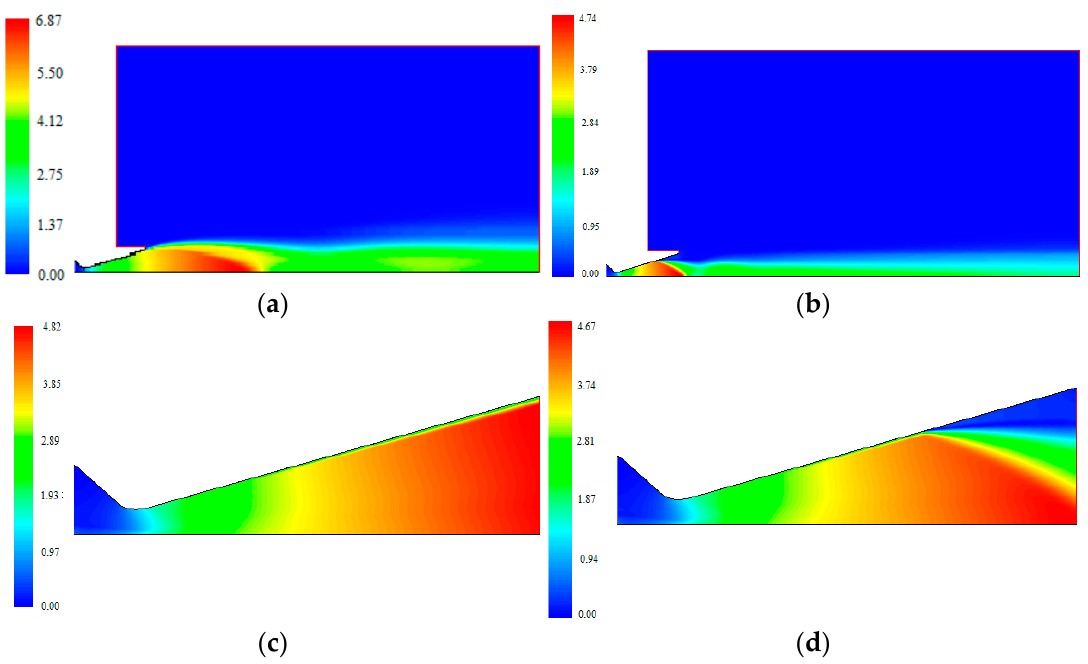
Figure 8. Mach number of cloud map of flow field, Pc = 4.34 MPa. ( a ) High altitude full field. ( b ) Ground full field. ( c ) High altitude infield. ( d ) Ground infield.